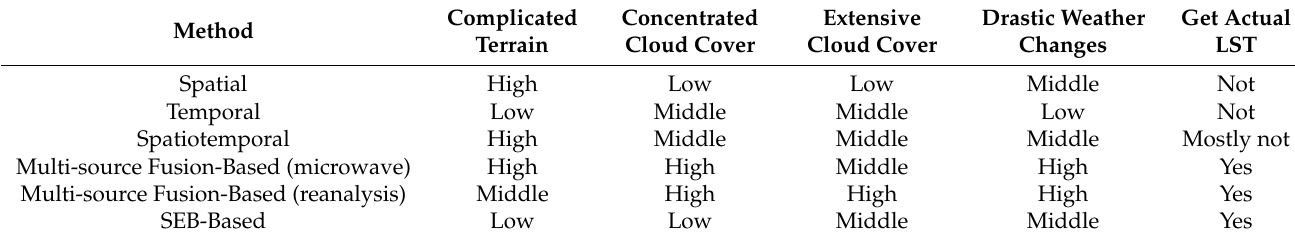
Table 9. Applicability of each gap-filling method under different